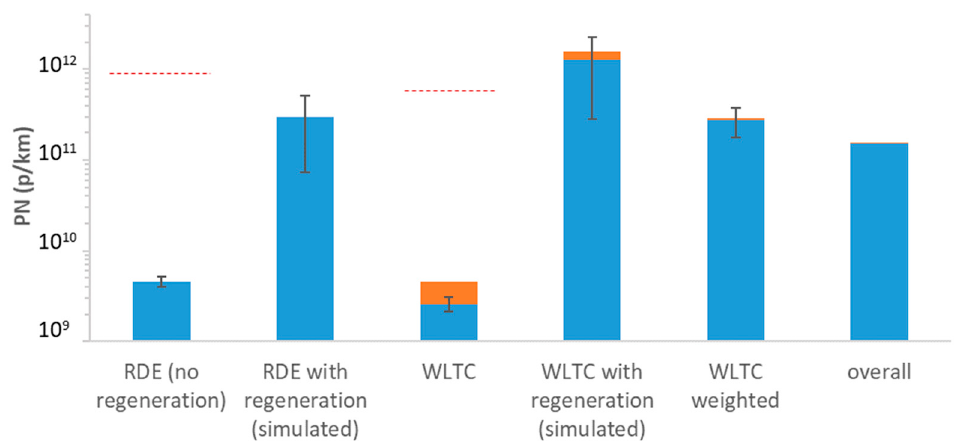
Figure 7. Nonvolatile particle number (PN) emissions > 23 nm and > 10 nm for the on-road real-driving emissions (RDE) and laboratory worldwide harmonized light-duty vehicles test cycle (WLTC) tests. Dotted lines give the PN limit in the laboratory and on the road.